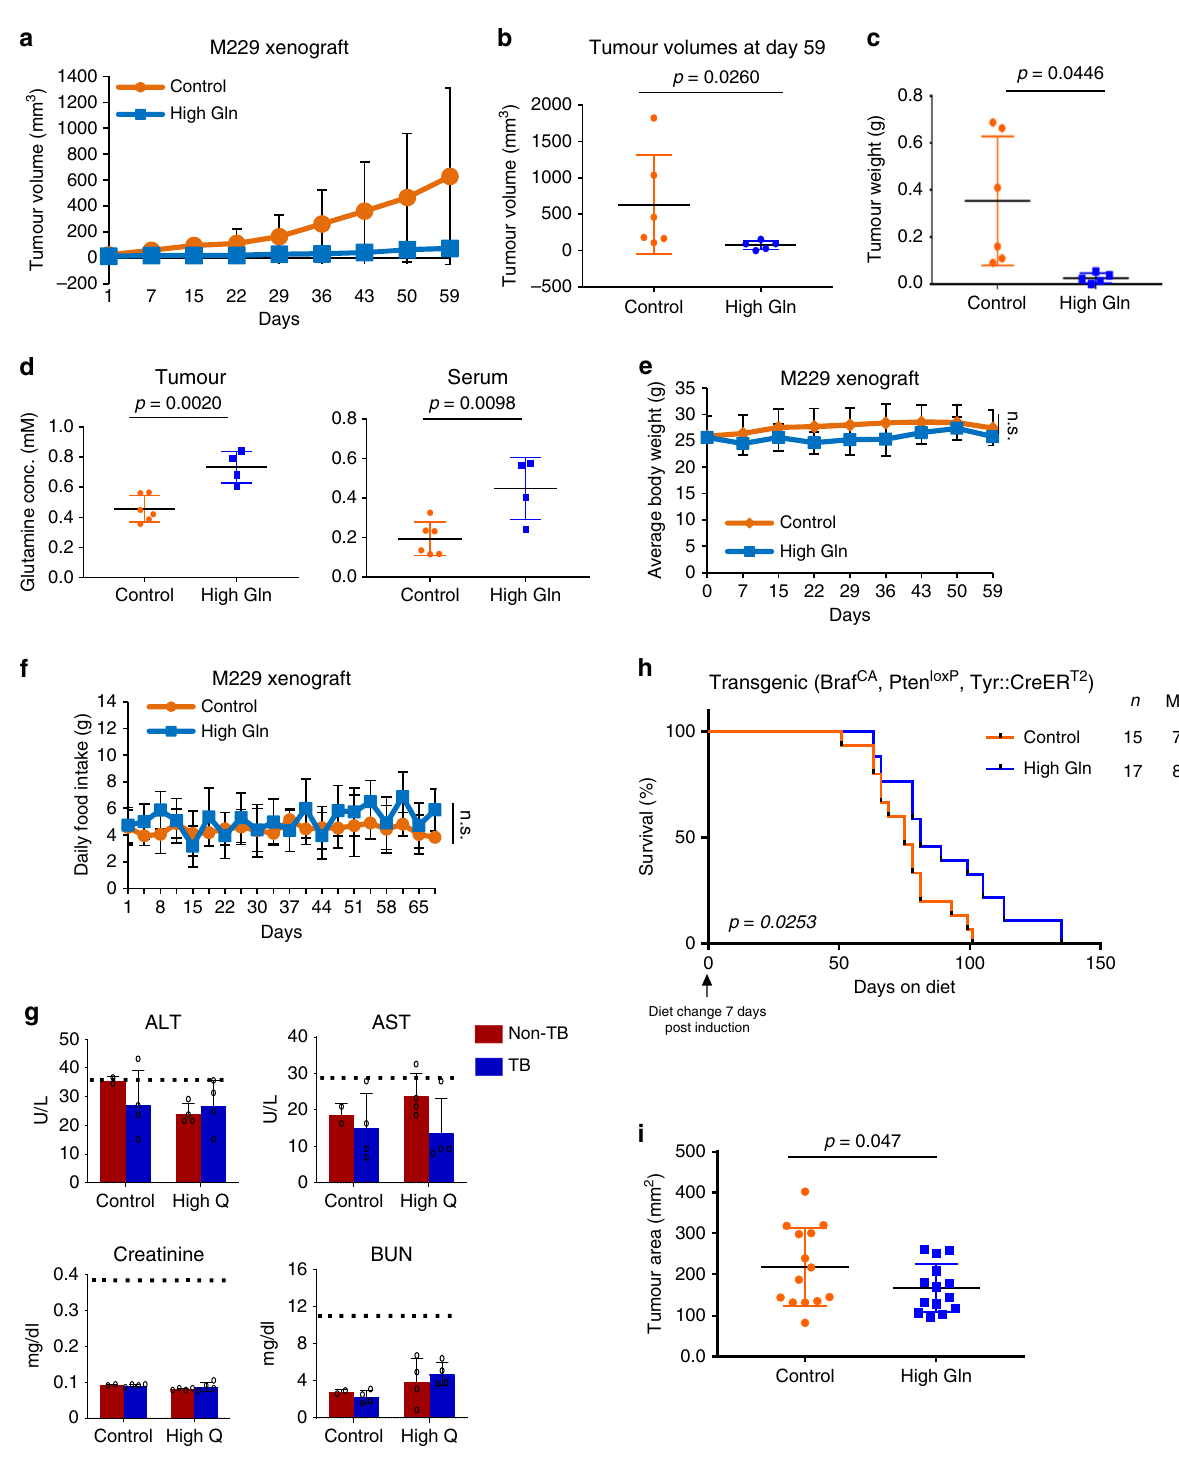
Fig. 2c, d). Serum and tumour tissues from both models showed increased glutamine levels in mice receiving the experimental diet (Fig. 3e, f), while having no signi fi cant effect on other amino acids (Supplementary Fig. 3). In addition to the marked difference in tumour volumes, cross-sections of PDX tumours from mice fed with glutamine-supplemented diet appeared to have more necrotic or apoptotic regions by haematoxylin and eosin (H&E) staining (Fig. 3g) accompanied by decreased proliferation by Ki67 staining compared to control (Fig. 3h and Supplementary Fig.